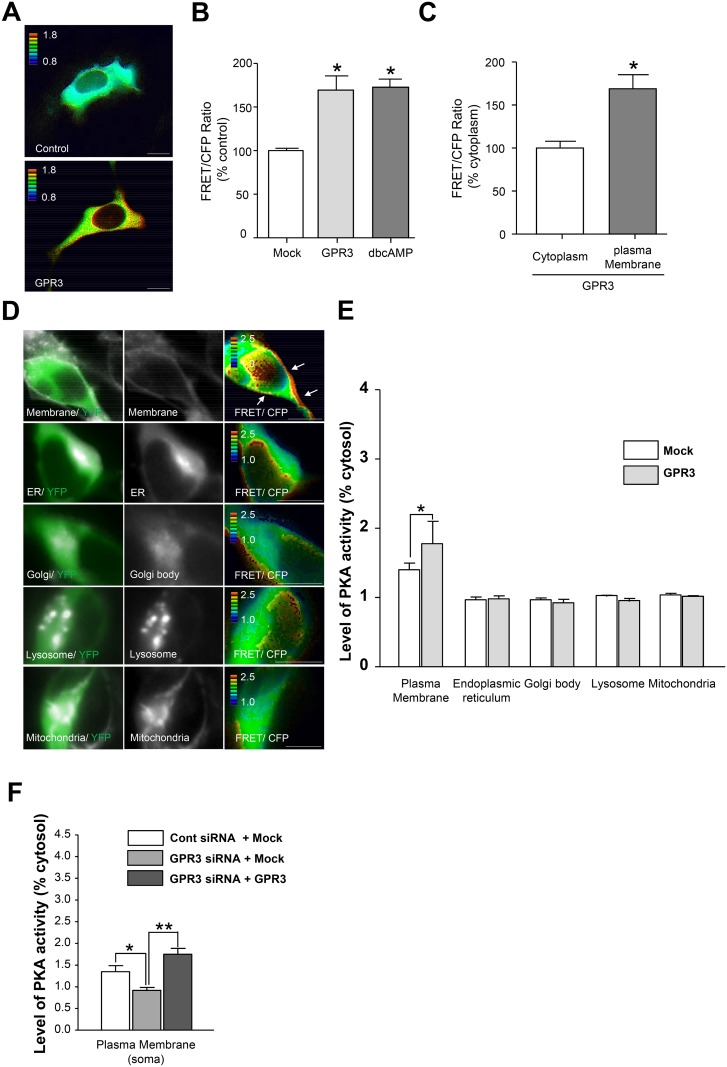
The GPR3-mediated modulation of PKA activity was analyzed with a PKA FRET indicator.(A-C) HEK293 cells were co-transfected with the AKAR3-EV and GPR3 expression plasmids. AKAR3-EV and the mock vector were co-transfected as a control. Forty-eight hours after transfection, the CFP and FRET images were captured using a fluorescent microscope. Some of the AKAR3-EV/mock vector co-transfected cells were treated with 1 mM dbcAMP 15 min before the images were captured. The FRET/CFP ratios in the images were analyzed by the MetaMorph software. (A) Representative images of cells transfected with either the mock vector (top) or the GPR3 vector (bottom) are shown. (B) The YFP/CFP ratio in each group were analyzed identically in each dish (n = 8). The values are expressed as the percentage of the FRET/CFP ratio in the GPR3-transfected or dbcAMP-treated cells compared to the mock-transfected cells, i.e., the percentage of the control vector-transfected cells. The means ± SEM were calculated for each condition. The asterisk (*) represents p < 0.001 compared to the cells transfected with the mock vector. (C) The FRET/CFP ratio in the cytoplasm and plasma membrane were evaluated in a single GPR3-transfected cell. The asterisk (*) represents p < 0.001 compared to the values for the cytoplasm. (D-E) The PKA activity in GPR3-expressing CGNs was evaluated by AKAR3-EV. CGNs were co-transfected with mock/AKAR3-EV or pGPR3-HT/AKAR3-EV expression plasmids. Forty-eight hours after transfection, the CGNs were stained with organelle-specific markers for the plasma membrane, ER, Golgi body, lysosome, and mitochondria. (D) Representative images of CGNs stained with CellMask (plasma membrane), ER tracker (ER), WGA633 (Golgi body), LysoTracker (lysosome), and MitoTracker (mitochondria) were shown (middle raw). The CFP/YFP ratios in the images were visualized and analyzed by the MetaMorph software (right raw). (E) The FRET/CFP ratios were compared in each organelle of the mock/AKAR3-EV- or pGPR3-HT/AKAR3-EV-transfected CGNs. The FRET/CFP ratios were significantly increased in the plasma membrane of the GPR3-HT-expressing CGNs compared to the mock-transfected CGNs. The data represent the means ± SEM for each condition (n = 6). The asterisk (*) represents p < 0.05. (F) The PKA activity in the plasma membrane around soma was analyzed in CGNs transfected with control siRNA+Mock, GPR3 siRNA+Mock, and GPR3 siRNA+ pGPR3-HT, respectively. Forty-eight hours after transfection, the FRET/CFP images were taken. The FRET/CFP ratio in each group were analyzed identically. The data represent the means ± SEM for each condition (n = 10). The asterisk (*) represents p < 0.05 and the double asterisk (**) represents p < 0.005.